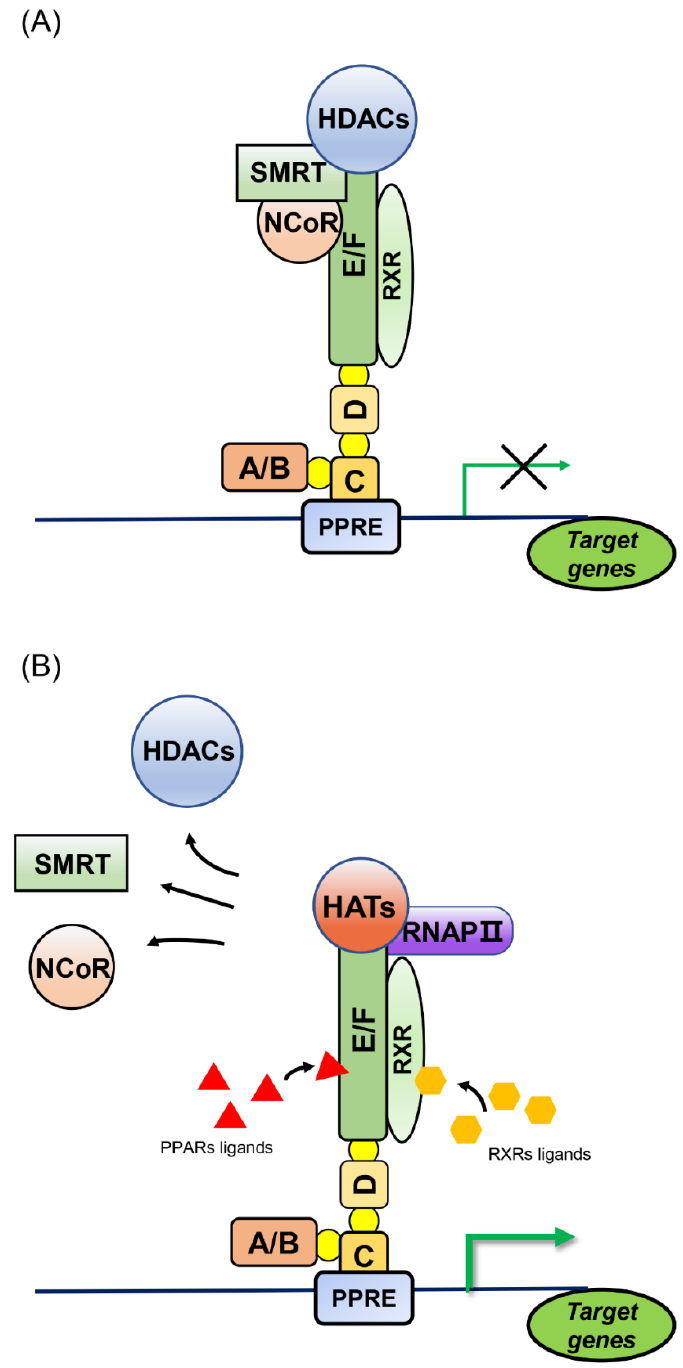
Figure 2. PPARs-mediated gene regulation. PPAR forms a heterodimer with RXR and binds to the PPRE element of the target gene promoter. In the absence of ligand binding, the heterodimer recruits transcriptional corepressors such as NCoR and SMRT, as well as HDACs, to repress target gene transcription ( A ). Upon ligand binding, PPAR changes conformation, releases transcriptional repressor complexes, and recruits transcriptional coactivators such as RNAPII and HATs to promote target gene transcription ( B ). A/B, C, D, E/F: PPAR domains; PPRE: peroxisome proliferator response element; RXR: retinoid X receptor; NCoR: nuclear receptor corepressor 1; SMRT: nuclear receptor corepressor 2; HDACs: histone deacetylases; HATs: histone acetyltransferases; RNAPII: RNA polymerase